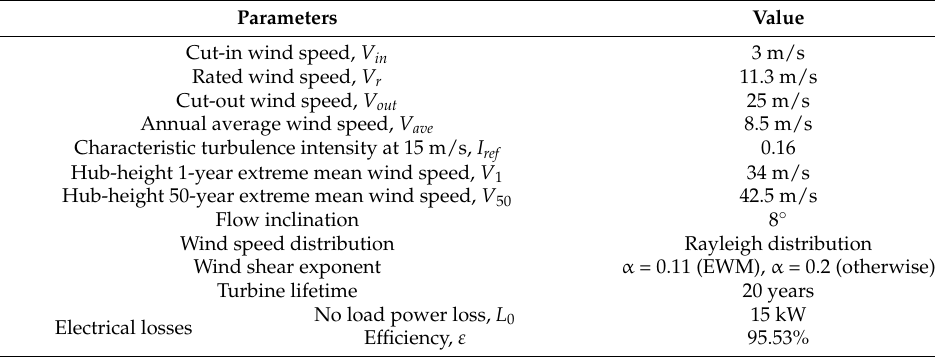
Table 2. Parameters of the 1.5 MW wind turbine.